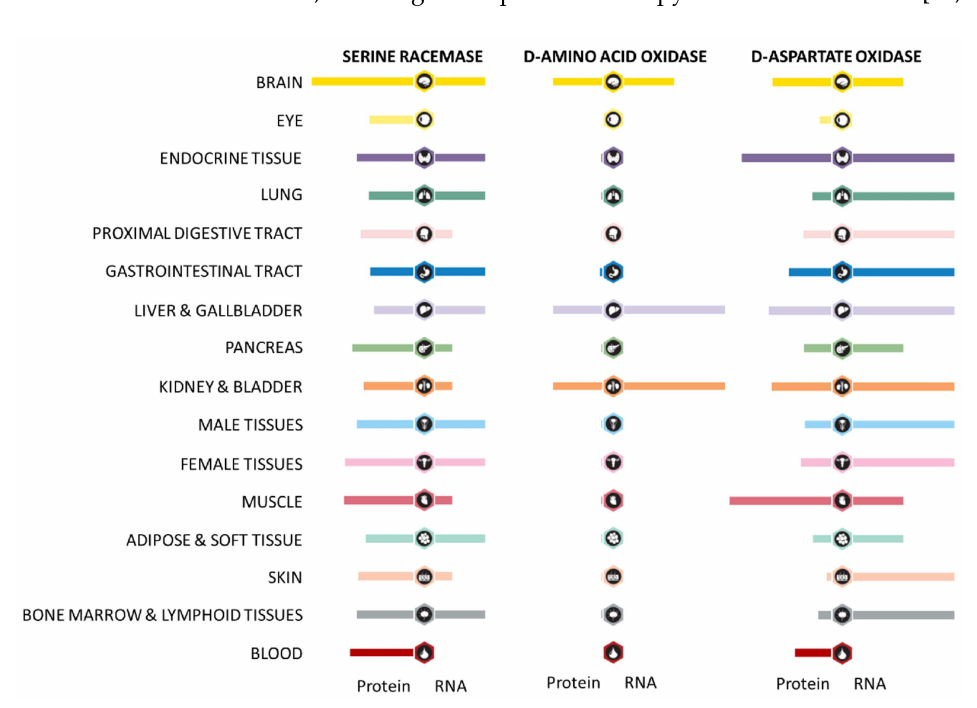
Figure 1. Overview of protein and mRNA expression profiles of enzymes involved in d -amino acid metabolism in di ff erent human tissues. Adapted from the Human Protein Atlas [72] (Version 19, available at https: //